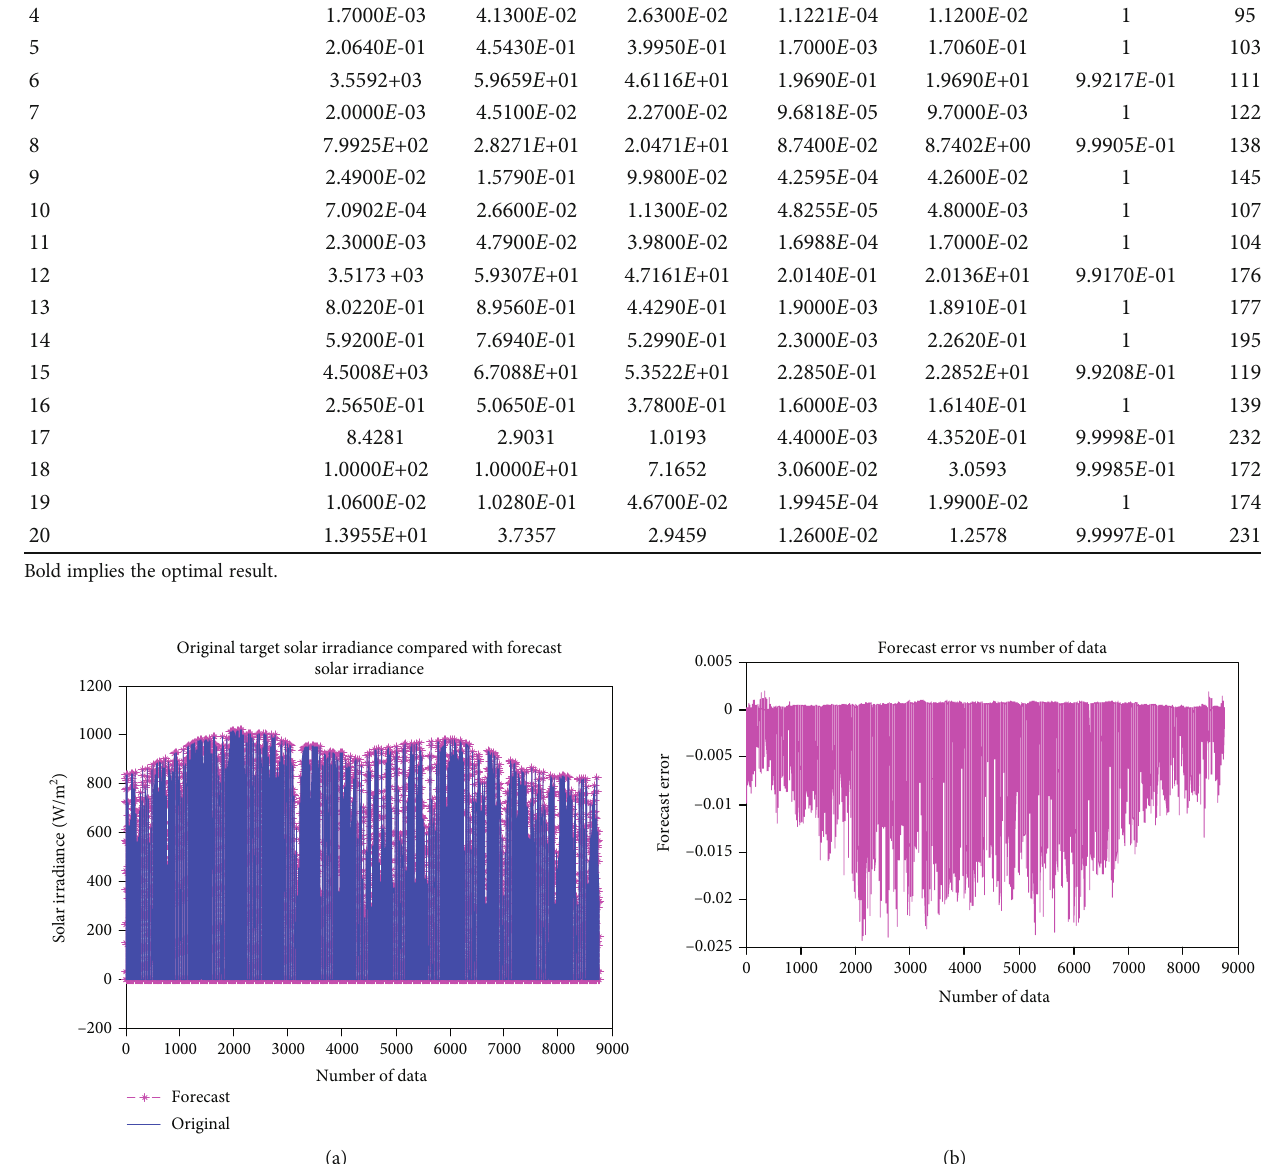
vs. the number of data samples and Figure 18(a): six input MLPNN-based forecasting model regression graphs. The designed model-based regression graph is linear in nature,